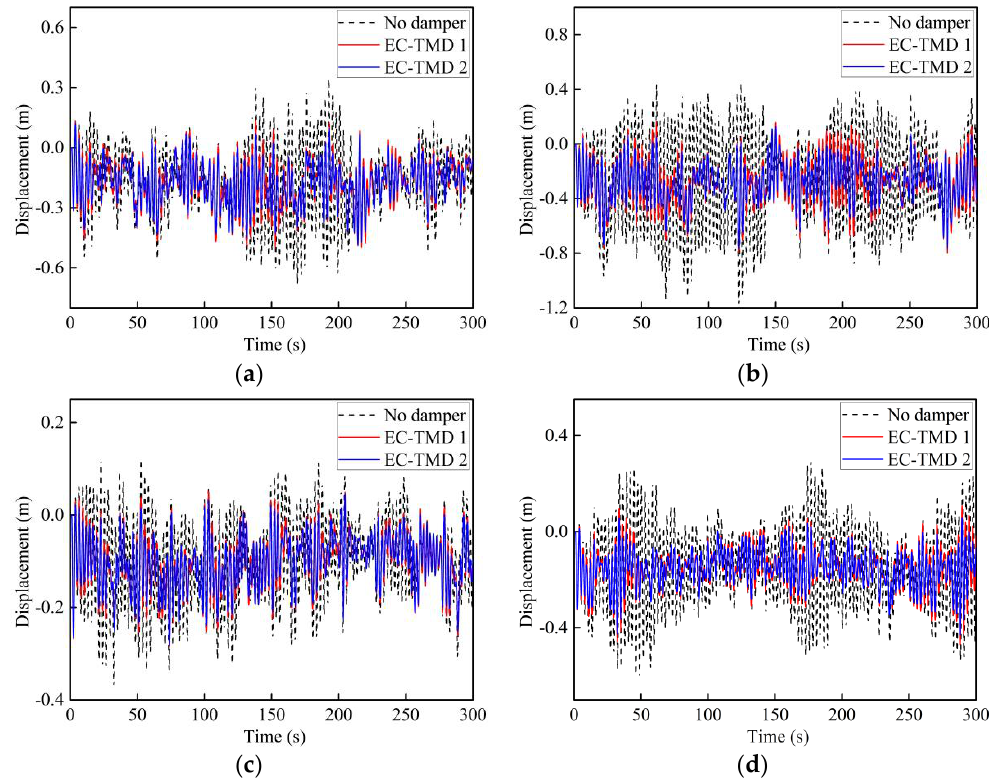
Figure 16. Displacement time histories with 1 and 50 years’ recurrence periods: ( a ) Class I with 1 year’s recurrence period; ( b ) Class I with 50 years’ recurrence period; ( c ) Class III with 1 year’s recurrence period; ( d ) Class III with 50 years’ recurrence period . Table 7. Peak values of displacements at the tower top for different cases.